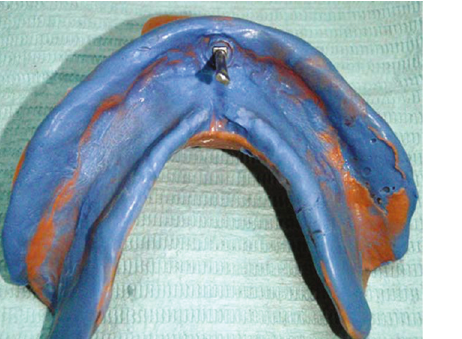
Figure 3: Transfer pin positioned in the impression before pouring. a plaque control protocol at the time of implant placement and this was reinforced at subsequent reviews.